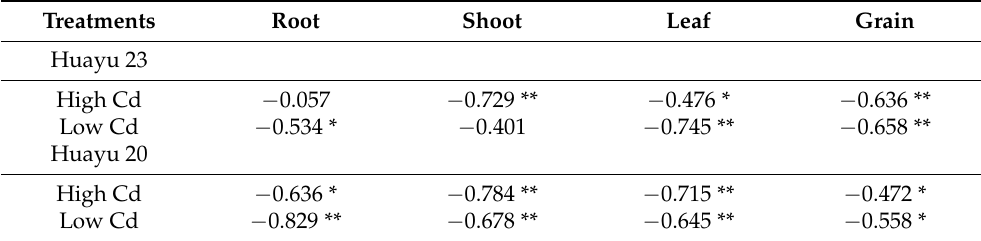
Table 7. Correlation analyses of Se and Cd content in Huayu 23 and Huayu 20 roots, stems, leaves, and grains under different treatments. Treatments Root Shoot Leaf Grain Huayu 23 High Cd − 0.057 − 0.729 ** − 0.476 * − 0.636 ** Low Cd − 0.534 * − 0.401 − 0.745 ** − 0.658 ** Huayu 20 High Cd − 0.636 * − 0.784 ** − 0.715 ** − 0.472 * Low Cd − 0.829 ** − 0.678 ** − 0.645 ** − 0.558